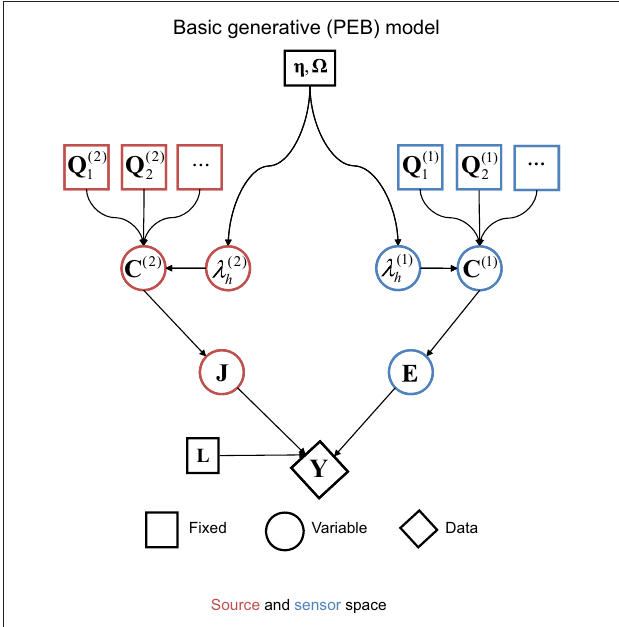
Figure 1 | A Bayesian dependency graph representing the basic generative model used for the eeg/Meg inverse problem for one subject and one sensor-type (modality) within the Parametric empirical Bayesian (PeB) framework. The variables are defined in Eqs 2–4 in the